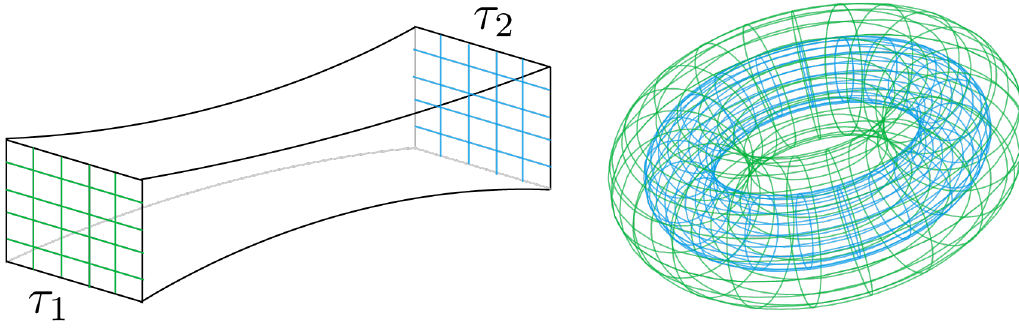
Figure 1 . The topology of the Euclidean wormhole is that of torus × interval, or equivalently annulus × circle. The outer and inner tori boundaries have an opposite sense of orientation from the bulk point of